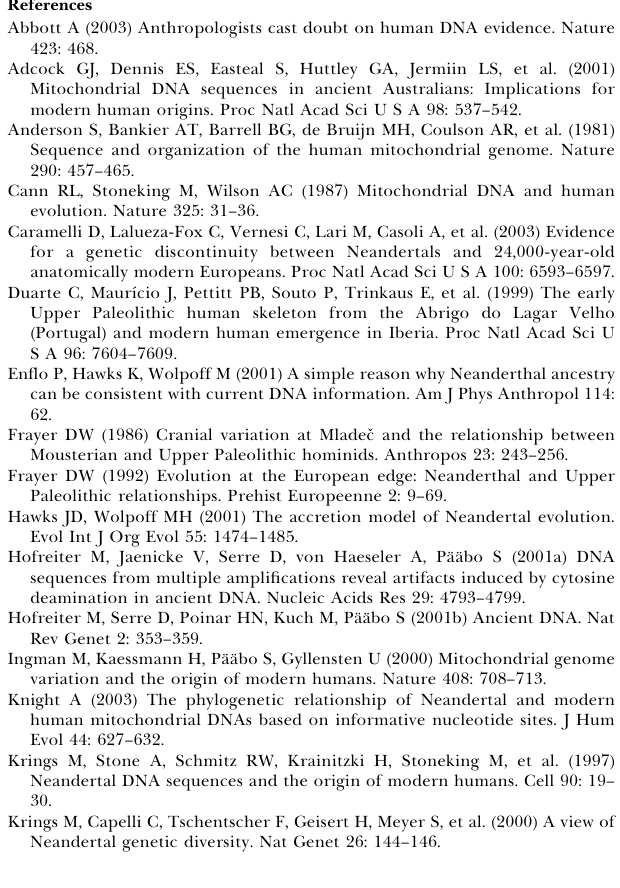
given different proportion of Neandertal contribution c (x axis) under a model of constant population size (see text; Materials and Methods). For example, the probability of observing only human mtDNA sequences given a Neandertal contribution of 25% or more is smaller than 0.05 (dotted line). Table S1. Results of the Amino Acid Analyses of 40 Human and 24 Neandertal Remains The bones were analyzed by high performance liquid chromatog- raphy for their amino acid content (see Materials and Methods). The extent of racemization of aspartic acid (D-/L-Asp), the ratio of glycine to aspartic acid (Gly/Asp), and the total amount of the eight amino acid analyzed (ppm) are given for each specimen. Zero indicates values below detection level. The five human and four Neandertal specimens from which DNA extraction were performed are displayed in